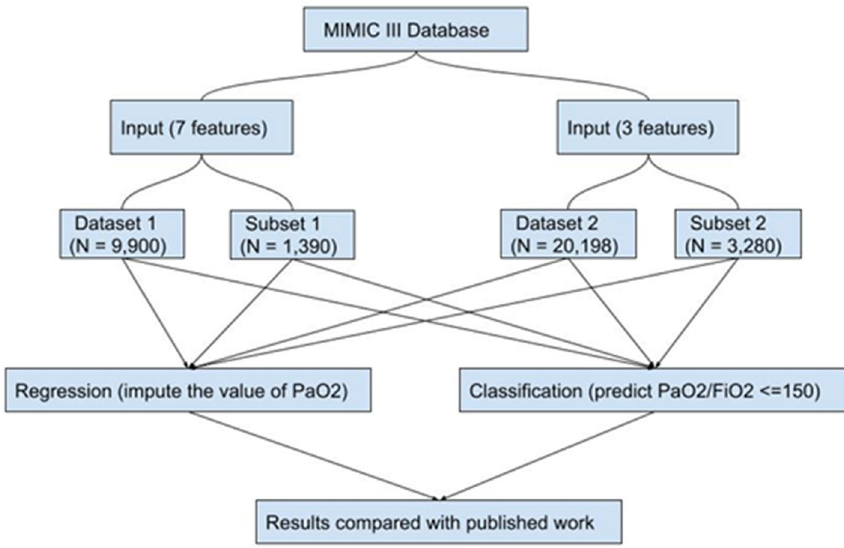
Figure 1. Overview of the experimental study design.